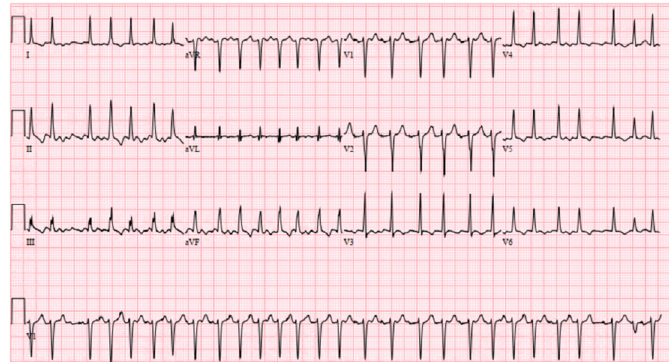
Image 3. Repeat electrocardiogram of a 55-year-old male on hemodialysis who presented to the emergency department with